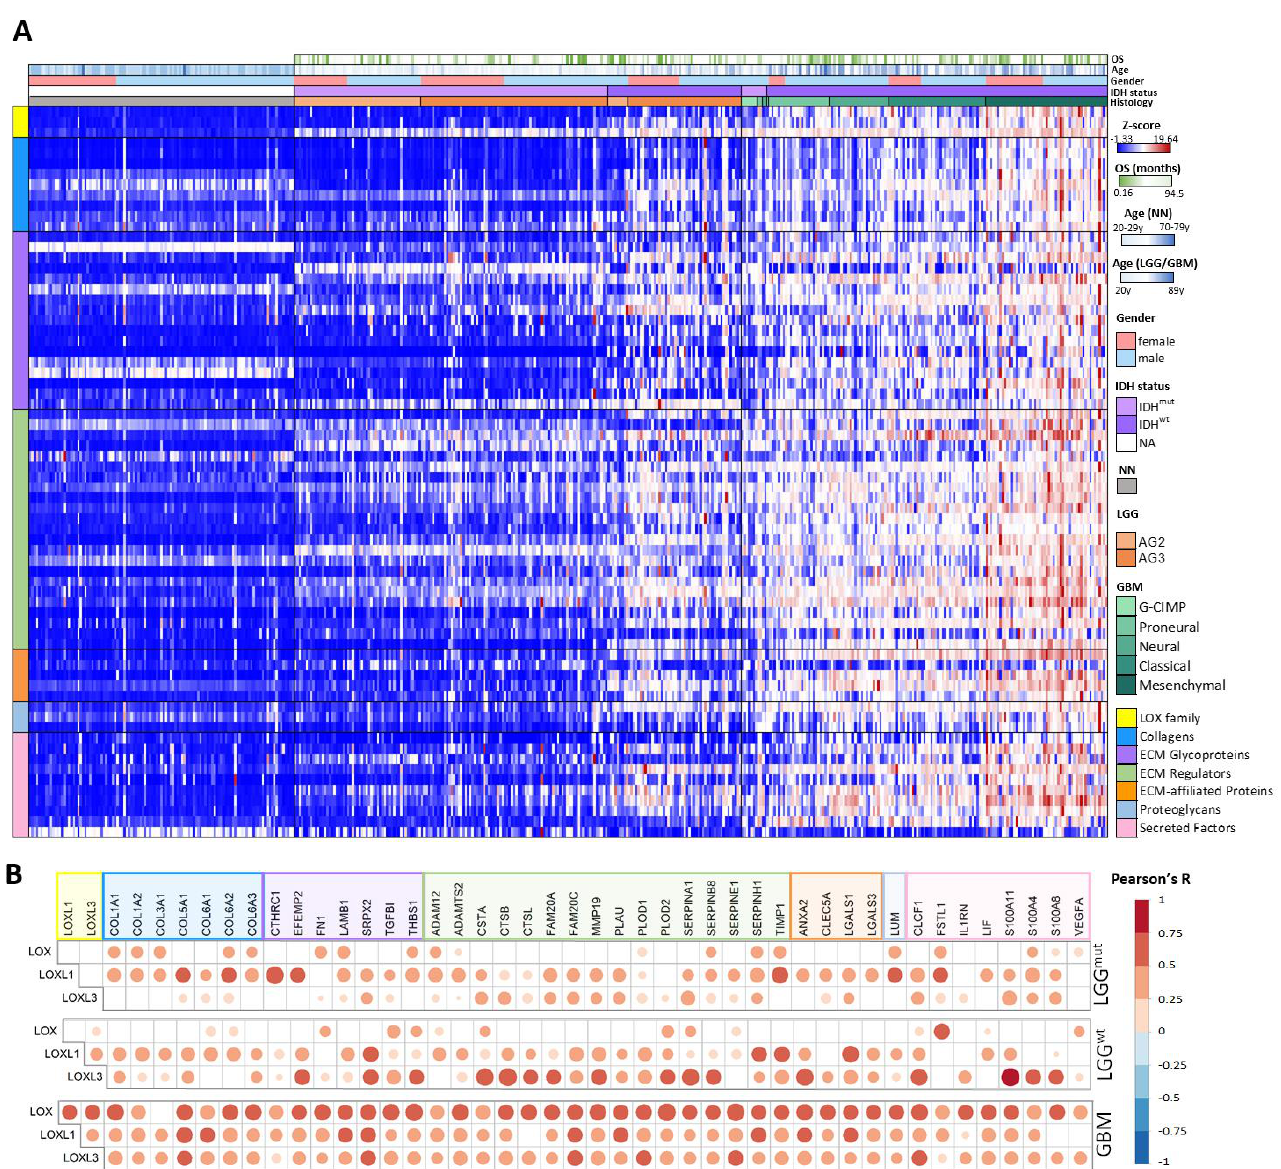
Figure 5. Lysyl oxidase family and matrisome gene expression analyses. ( A ) Heatmap of lysyl oxidase family and matrisome genes in non-neoplastic brain samples and diffuse astrocytomas with IDH mutation status and different subtypes of glioblastoma. The 70 genes selected using the workflow presented in Figure 4 are depicted in the heatmap of z-score of normalized read counts. ( B ) Pearson’s correlation coefficient test of LOX , LOXL1 , and LOXL3 and matrisome genes in LGG IDH mut , LGG IDH wt , GBM groups. Abbreviations: AG2, low-grade astrocytoma; AG3, anaplastic astrocytoma; ECM, extracellular matrix; GBM, glioblastoma; IDH mut , isocitrate dehydrogenase gene with mutation; IDH wt , isocitrate dehydrogenase gene wild type; LGG, lower-grade astrocytic glioma; NA, not analyzed.